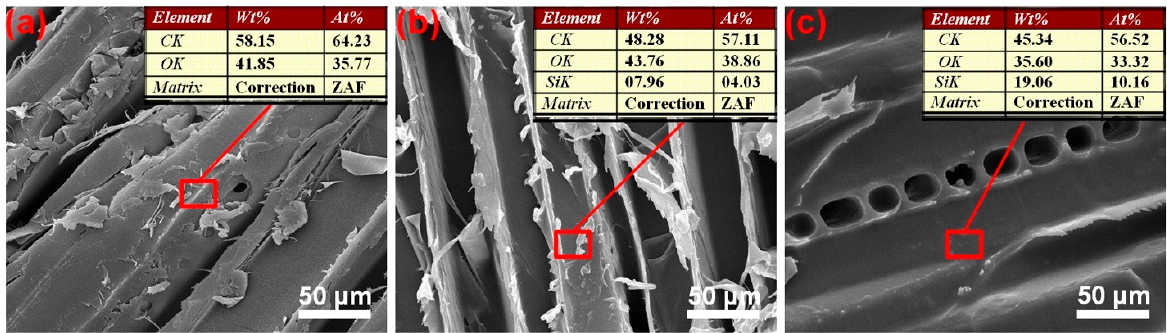
Figure 5. SEM images and EDS analysis of wood treated with different inhibitor contentscontent: original wood ( a ), 42% ( b ), 56% ( c ).